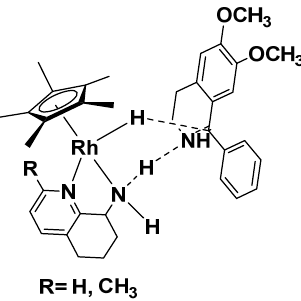
Figure 3. Hypothesis of interaction between the ligand L1 or L2 with the substrate.